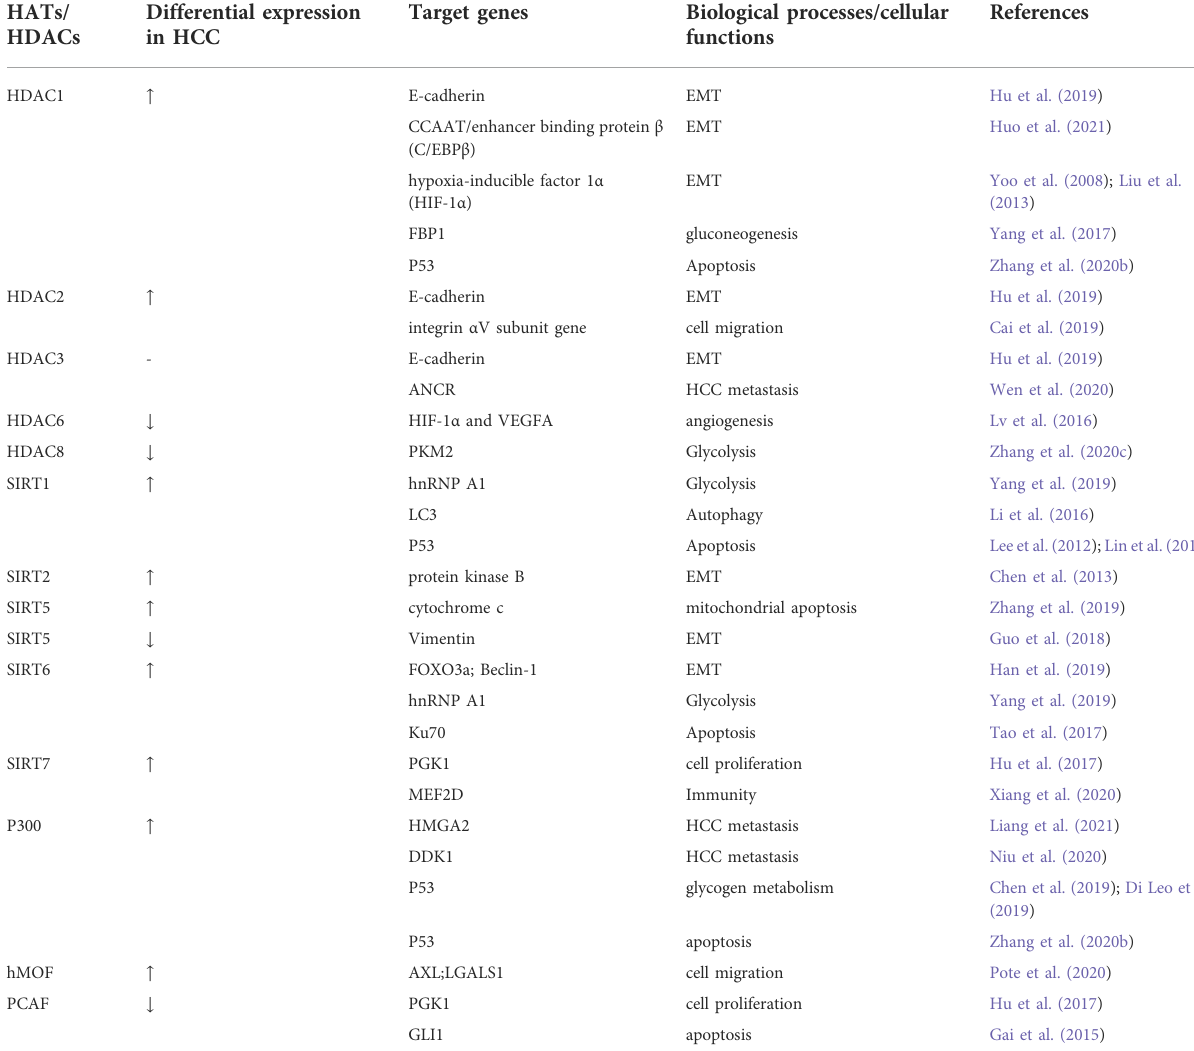
TABLE 4 Expression and target genes of HATs/HDACs in HCC. HATs/